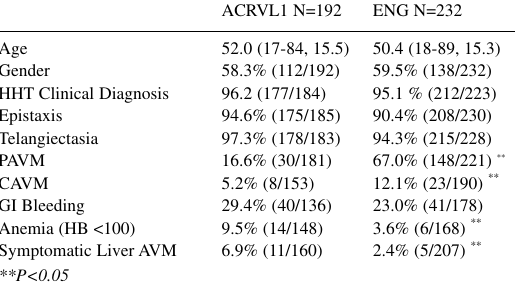
Table 1. Genotype phenotype associations in Canadian HHT pop-